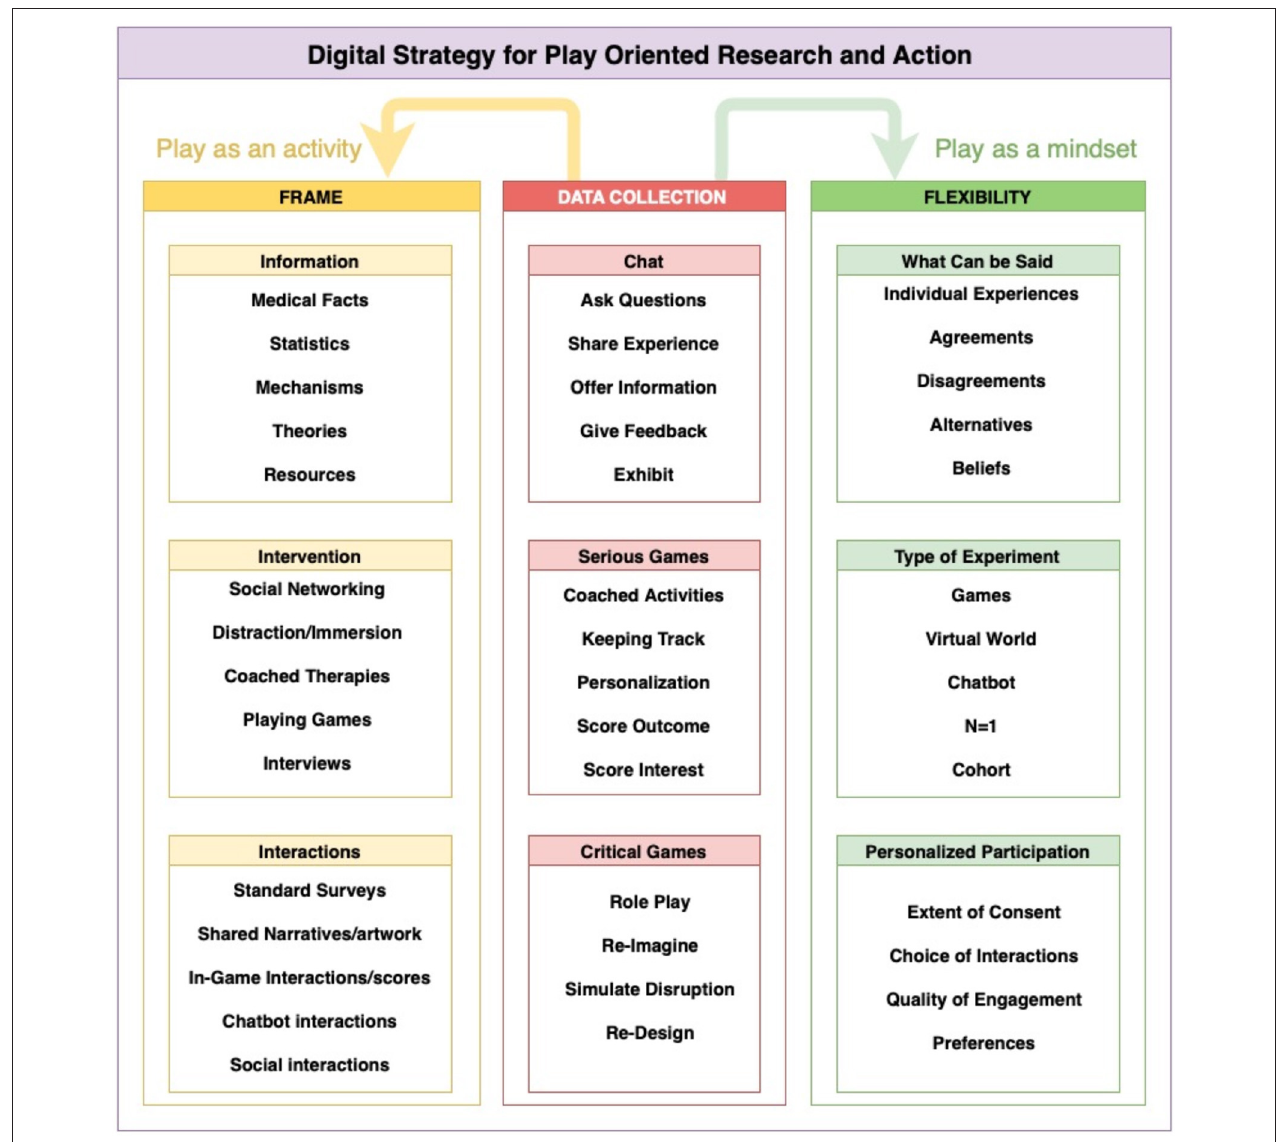
FIGURE 3 | A schematic representation of DiSPORA. Set up similarly to a science museum, the DiSPORA research environment is framed by a set of digitally implemented modules that provide information, offer tools for experimenting with suggested interventions, and capture data from interactions. Play is implemented as a strategy for data collection, encouraging a playful mindset (playing with different ideas) and providing a framework for activities (chatbots, serious games, simulated worlds). The system is designed to be flexible, allowing participants to share ideas or beliefs, decide on the type of experimentation and knowledge generation, select activities, and choose the type and extent of data-sharing they prefer and for which they give explicit